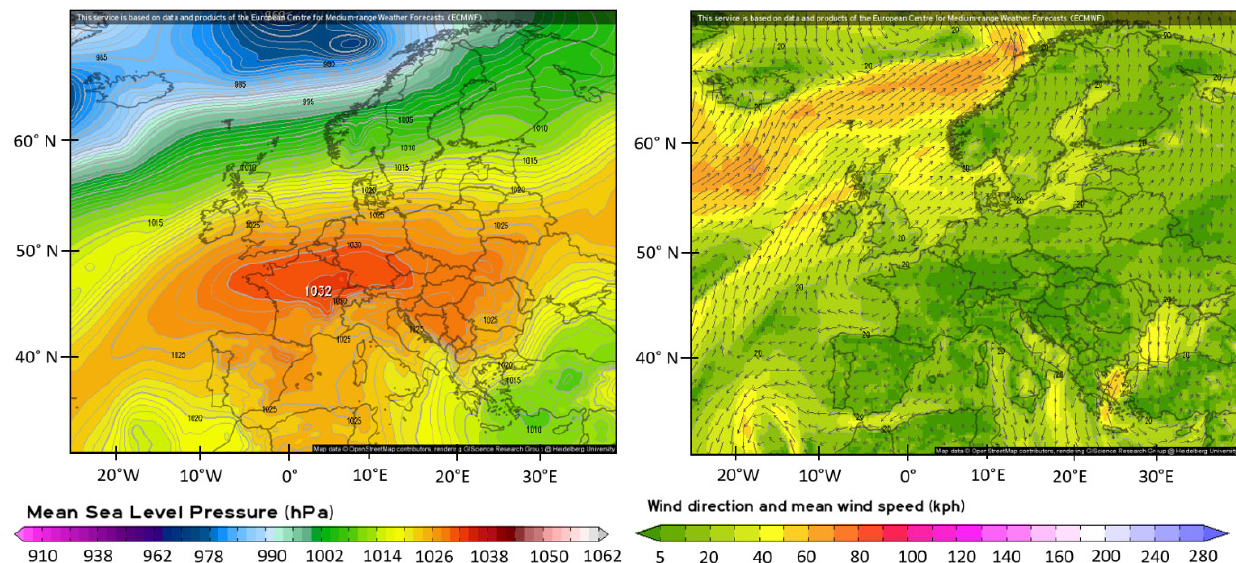
Figure 6. Sea ‐ level pressure (left) and 10 m wind directions and speeds by ECMWF reanalysis for 15 December 2021. On the left, colors indicate the mean sea ‐ level pressure and lines highlight the isobars. On the right, arrows indicate the wind direction and the colors indicate the wind speeds. Source: (meteorologix.com, accessed on 8 February 2023).